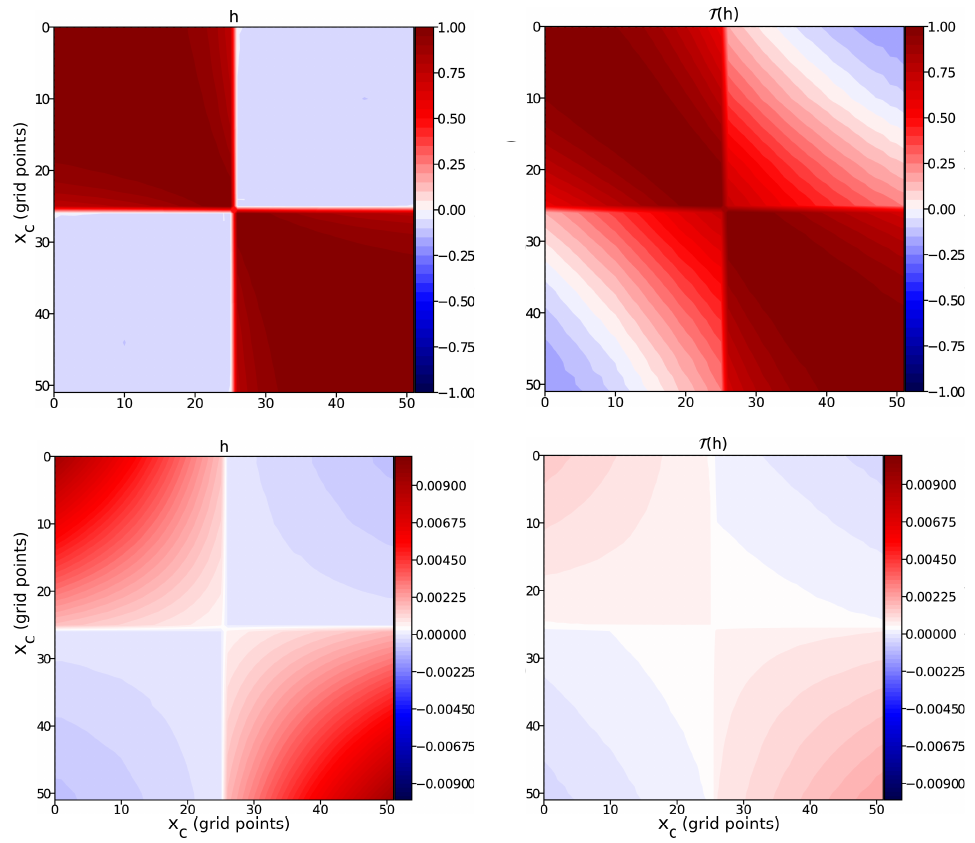
Figure 5. The across-track correlations (top) and across-track covariances (bottom) of the SWOT data h (left) and the detrended SWOT data T ( h )